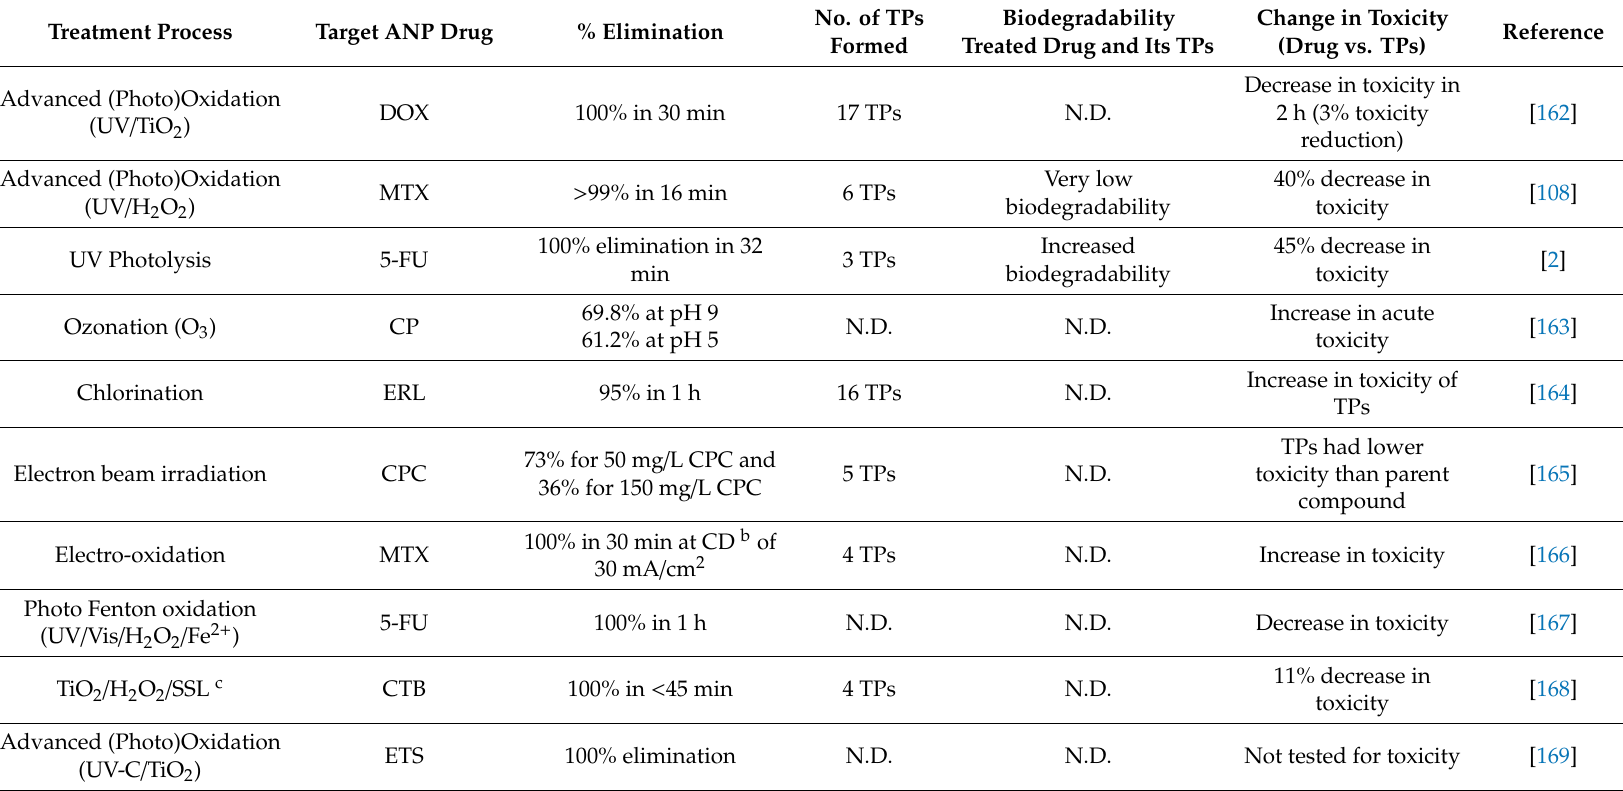
Table 4. Studies on removal of ANP agents using physico-chemical and oxidation